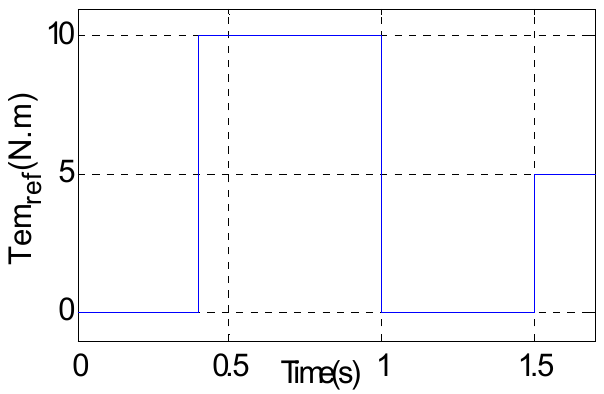
Figure 8. Load torque application.